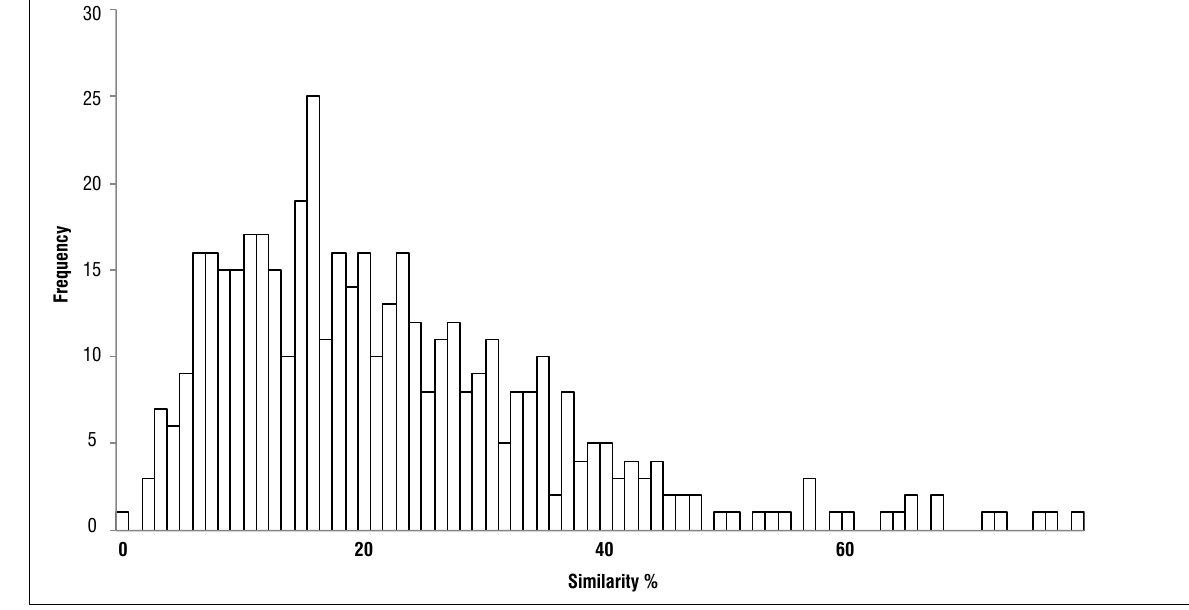
Figure 1: Distribution of the similarity index across 454 submissions